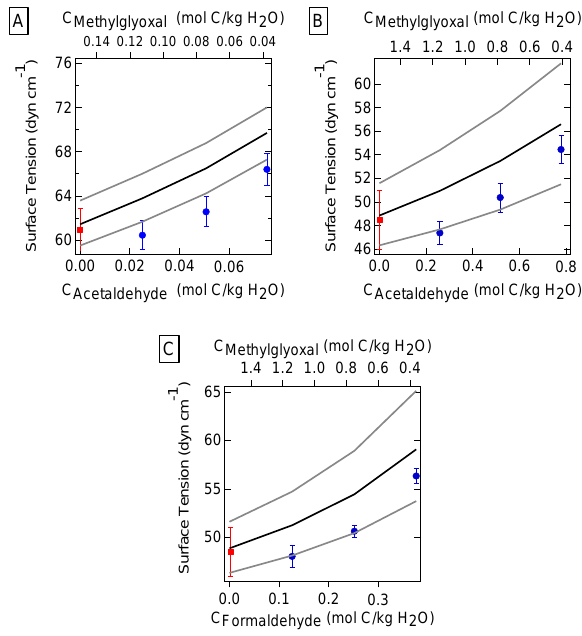
Figure 2. Surface tension of binary mixtures of acetaldehyde or formaldehyde with MG in 3.1 M AS solutions. The total organic concentration was 0.05 M ( A ) or 0.5 M ( B, C ). The black line shows Henning model predictions (Eq. 3) using the parameters listed in Table 1. The grey lines show the confidence interval of the model predictions. Red: MG in AS (based on the Szyszkowski-Langmuir equation (Eq. 2), using the parameters in Table 1). Blue: acetaldehyde ( A and B ) or Formaldehyde ( C ) with MG in 3.1 M AS solutions.